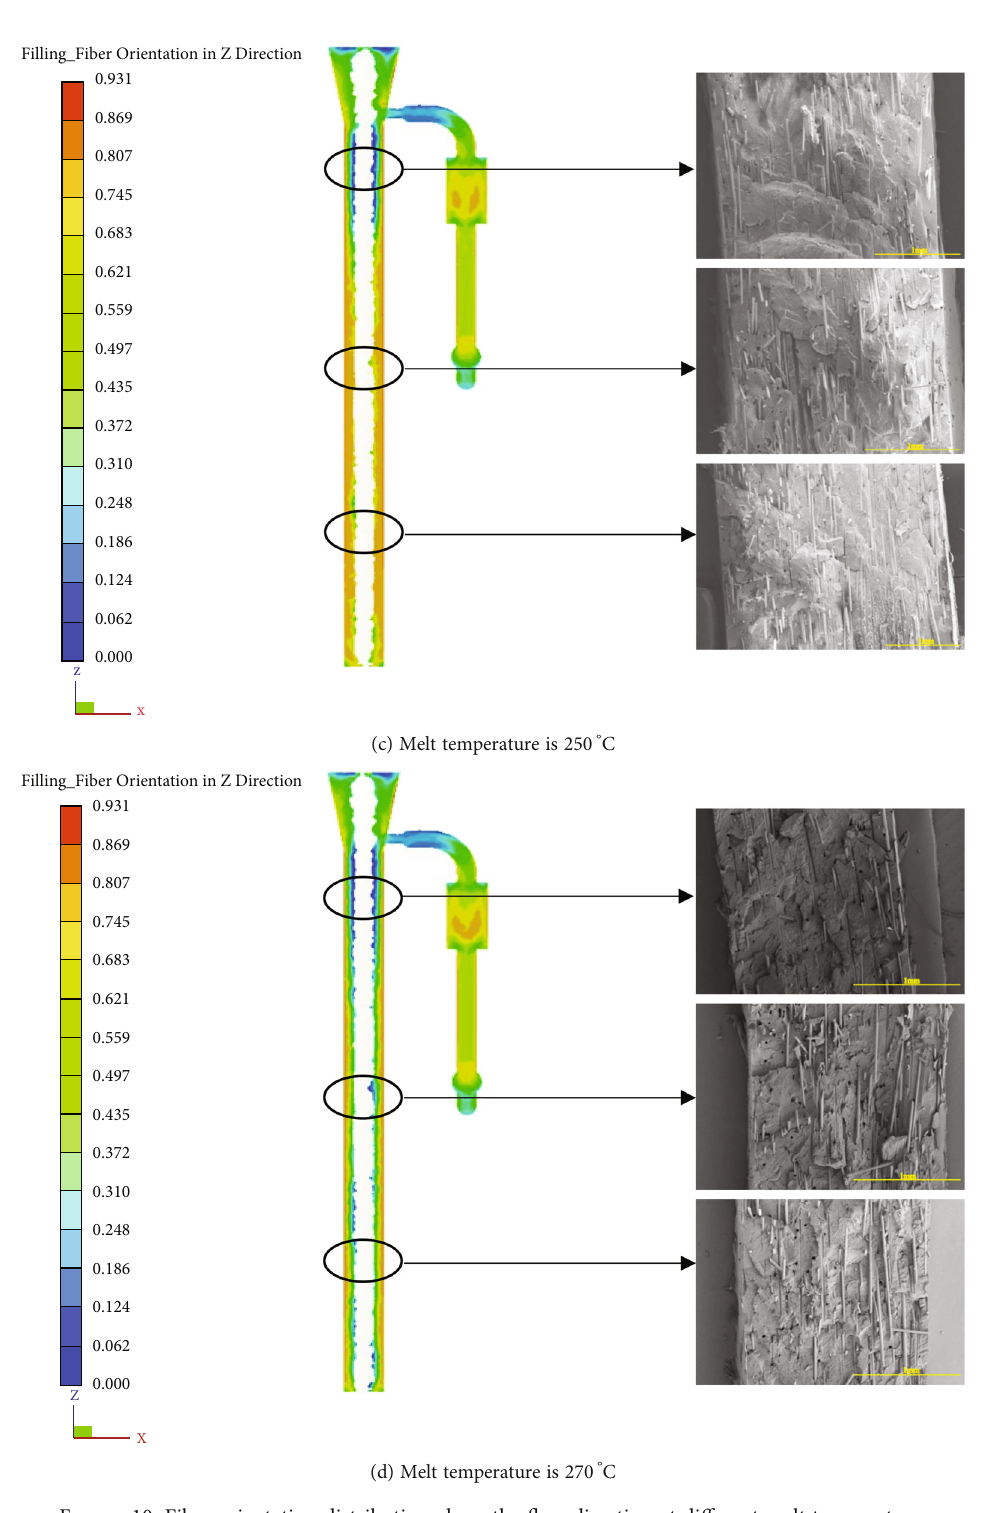
Figure 11: The highest shear rate gradient is at the melt tem-